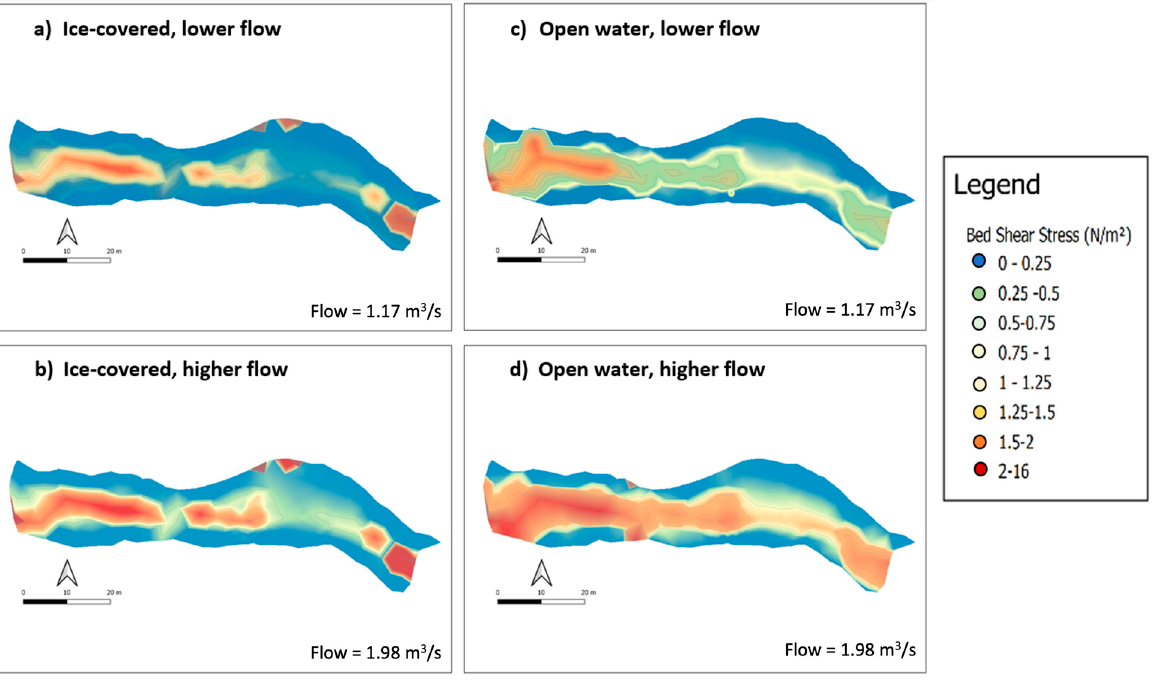
Figure 8. Bed shear stress distribution under lower flow, ice-covered conditions ( a ); lower flow, open-water conditions ( b ); higher flow, ice-covered conditions ( c ); and higher flow, open-water conditions ( d ). Prepared in QGIS.